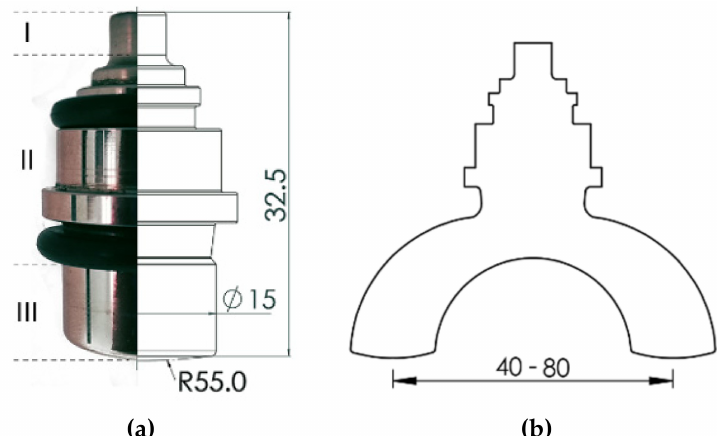
Figure 5. Conventional ( a ) and predesigned dual-tip ( b ) shockwave applicator schematic representation and dimensions in